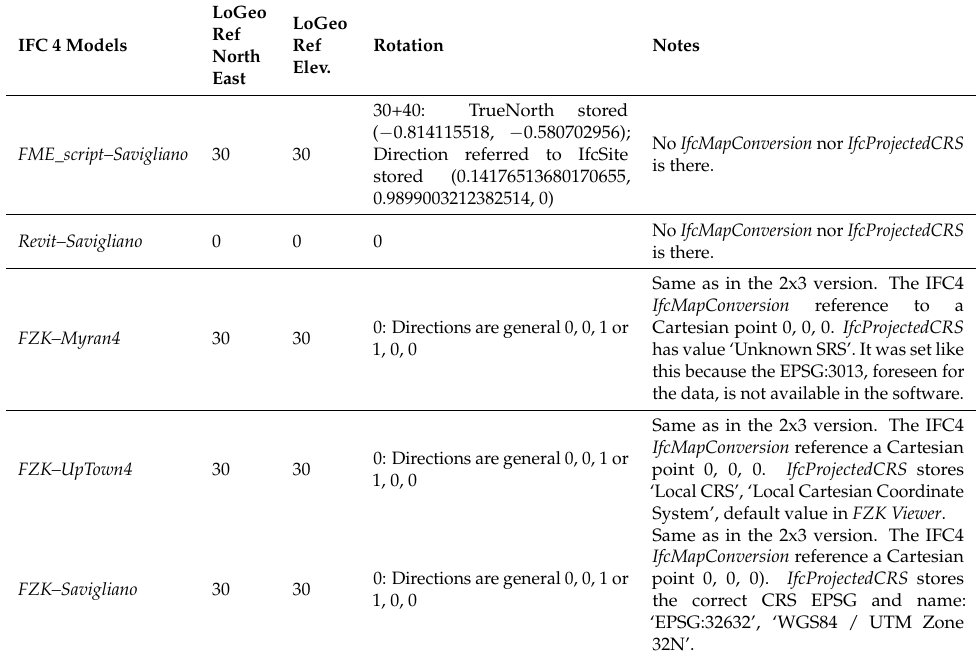
Table 7. Results of the applied georeferencing procedures to the models, exported in IFC v.4 by